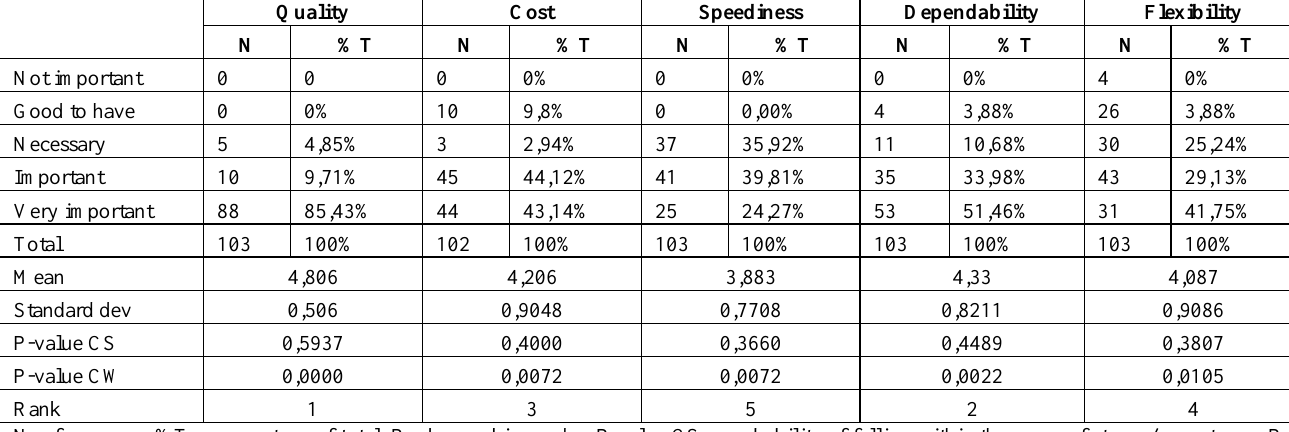
Table 7: Future importance of competitive operations priorities to compete better internationally Quality